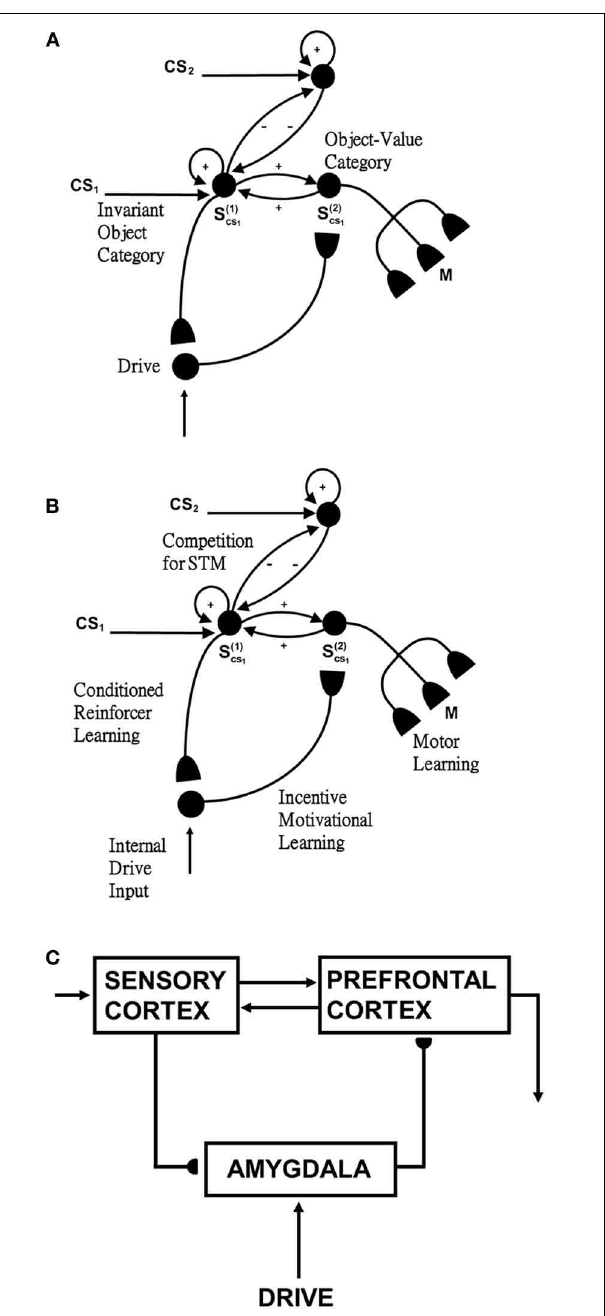
FIGURE 4 | Reinforcement learning circuit of the CogEM model (Grossberg, 1971, 1975; Grossberg and Seidman, 2006). (A) Processing stages of invariant object category, object-value category, and drive representation (value category) representations. CS, conditioned stimuli; S, sensory representations; and M, motor representations. (B) Conditioned reinforcer learning enables sensory events to activate emotional reactions at drive representations. Incentive motivational learning enables emotions to generate a motivational set that biases the system to process information consistent with that emotion. Motor learning allows sensory and cognitive representations to generate actions. (C) Anatomical interpretations of the processing stages. [Adapted from Grossberg and Seidman (2006), Figures 4, 5, with